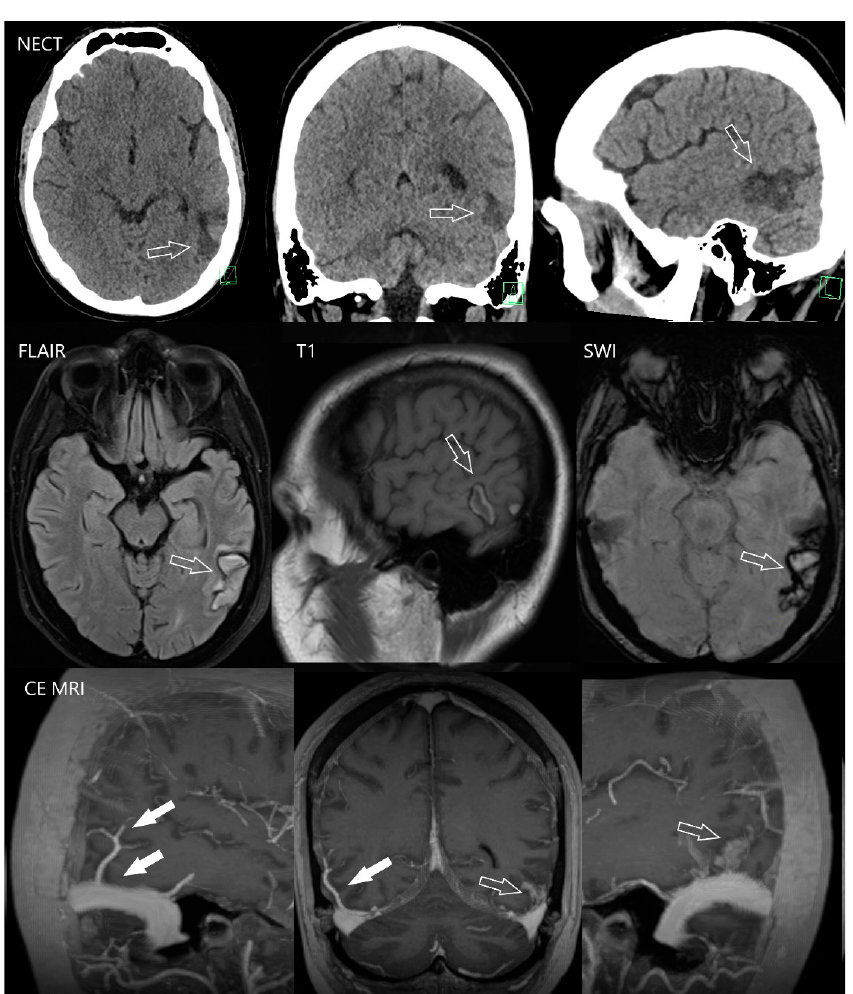
Figure 2. Cerebral venous infarction due to occlusion of the vein of Labb é . 21-year-old male with history of long-term lasting ulcerative colitis treated by vedolizumab and azathioprine. He came